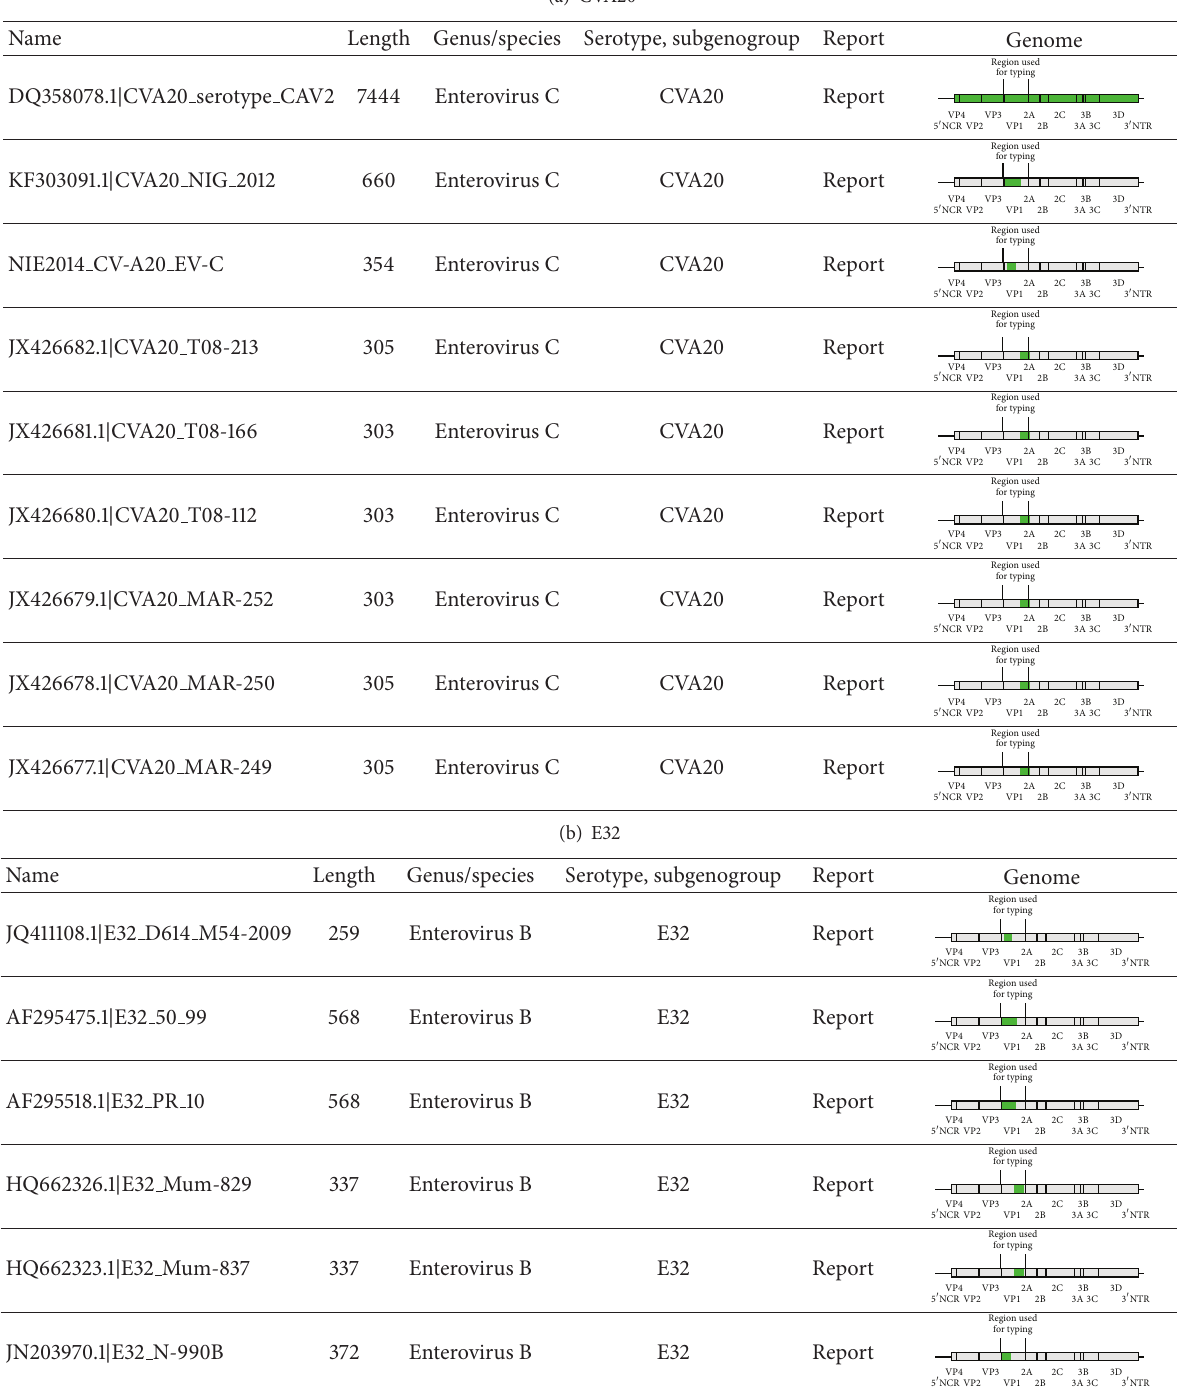
Table 2: Enterovirus genotyping tool (EGT) identification of isolates and graphic view of the region of the enterovirus genome represented by the query nucleotide sequence(s). This graphic view was generated by the enterovirus genotyping tool [28]. (a) shows CVA20 sequences while (b) shows E32. Column 1 shows the sequence ID (or accession number); column 2 shows the number of nucleotide sequences; column 3 shows the species to which the isolate belongs; column 4 shows the serotype of the isolates; column 5 shows a hyperlink (report) to more information on the alignment generated by the software (note: the hyperlink is generated afresh for every sequence data imputed into the enterovirus genotyping tool and is a temporary link that ceases to exist not long after a guest leaves the EGT); and column 6 shows a graphic view of the region of the enterovirus genome represented by the query